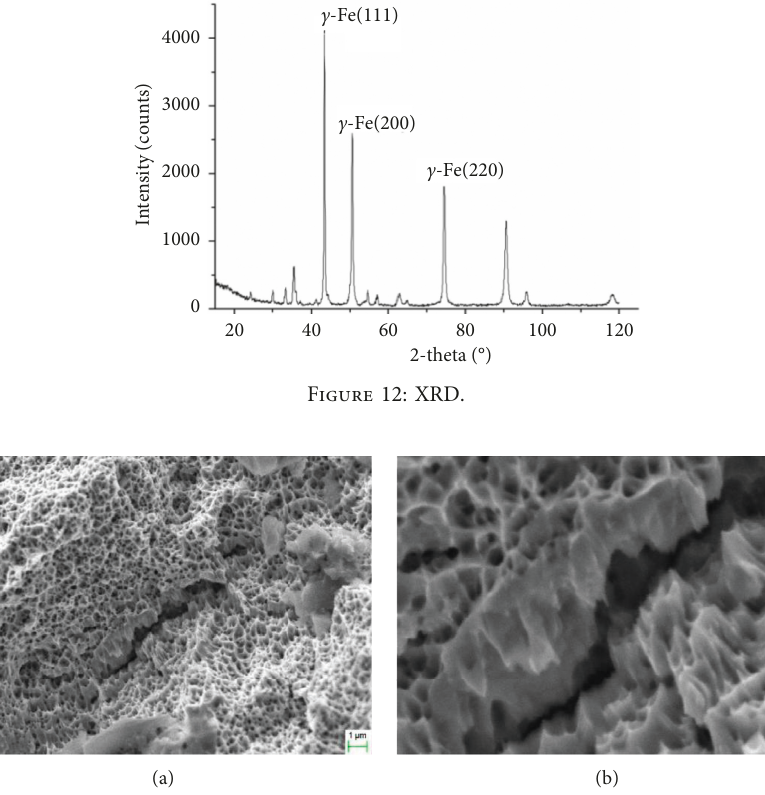
Figure 13: Fracture morphology. (a) Dimple morphology. (b) Crack.